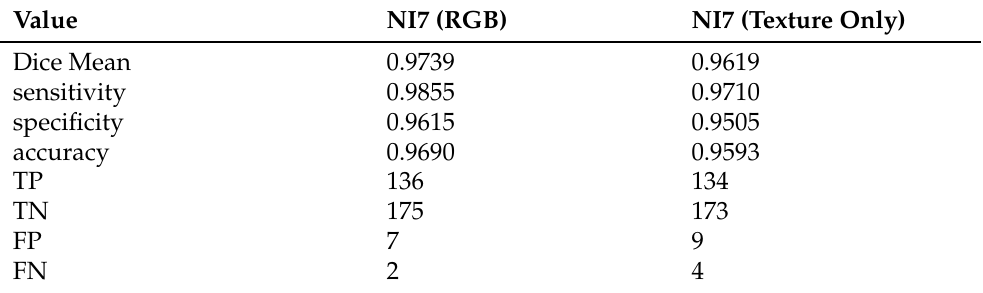
Table 6. Ni7 material segmentation results.